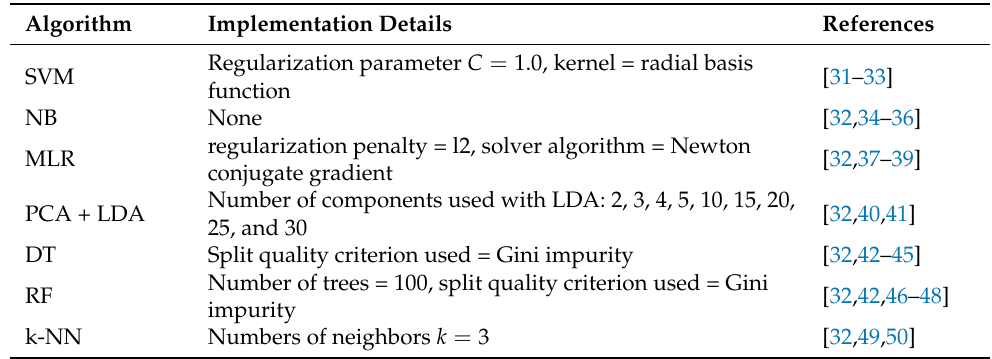
Table 2. List of the machine learning methods used, with implementation parameters and references to the methods description: Support vector machine (SVM), naïve Bayes (NB), multinomial logistic regression (MLR), principal component analysis (PCA) and linear discriminant analysis (LDA), decision tree (DT), random forest (RF), and k-nearest neighbor